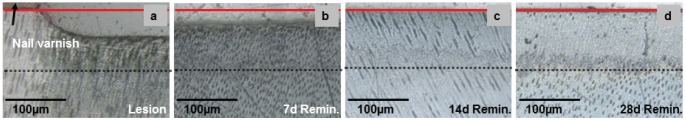
Shrinkage decreased with increased remineralization.Optical images of dried cross sections exposing the lesion depths. a) demineralized lesion with nail varnish shown protecting the unexposed surface; b) shrinkage was greatly decreased at 7days and was almost undetectable at c) 14 days; or d) 28 days. Solid red line  =  original surface location, black dotted line  =  lesion depth.